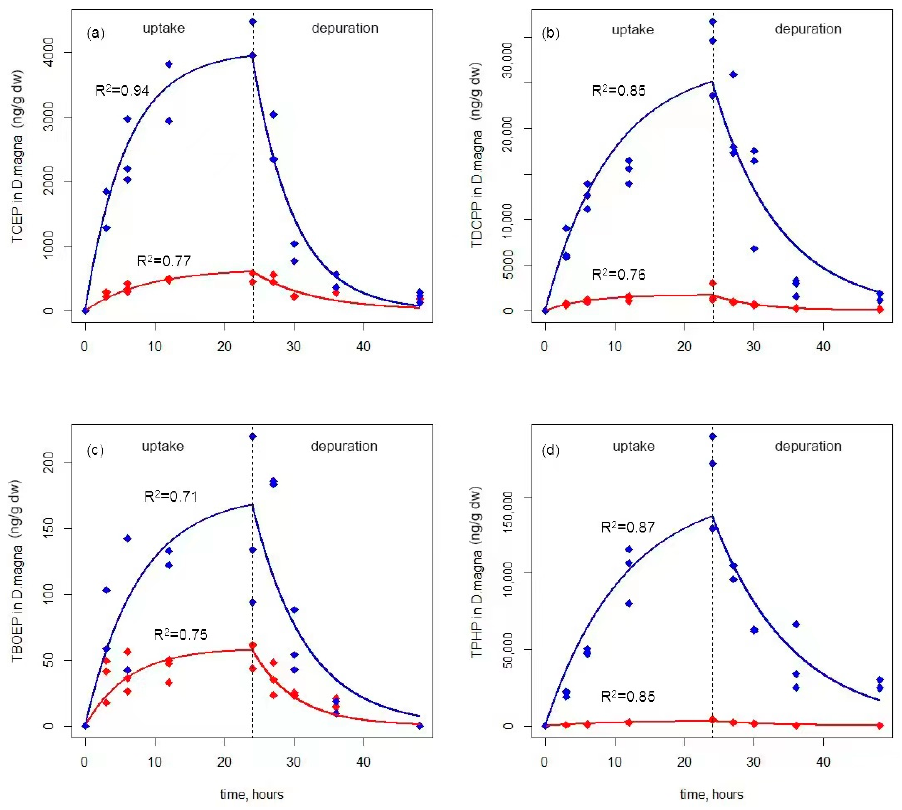
Figure 1. Uptake (0–24 h) and depuration (24–48 h) kinetics of four OPEs (( a ) TCEP, ( b ) TDCPP, ( c ) TBOEP, ( d ) TPHP) in D. magna via waterborne exposure. Blue lines (toxicokinetics model simula- tions) and points (experimental data) represent the high-concentration group (100 µ g/L), and red lines (toxicokinetics model simulations) and points (experimental data) represent the low-concentration group (20 µ